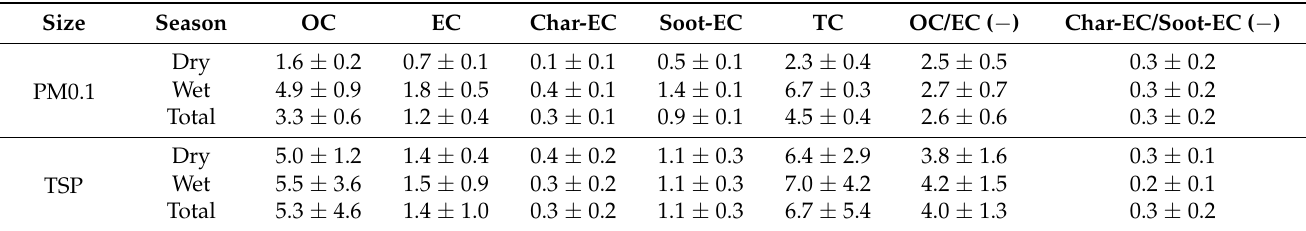
Table 3. Average seasonal and total concentrations of OC, EC, Char-EC, Soot-EC, TC ( µ g/m 3 ) and OC/EC, Char-EC/Soot-EC ratio in Hat